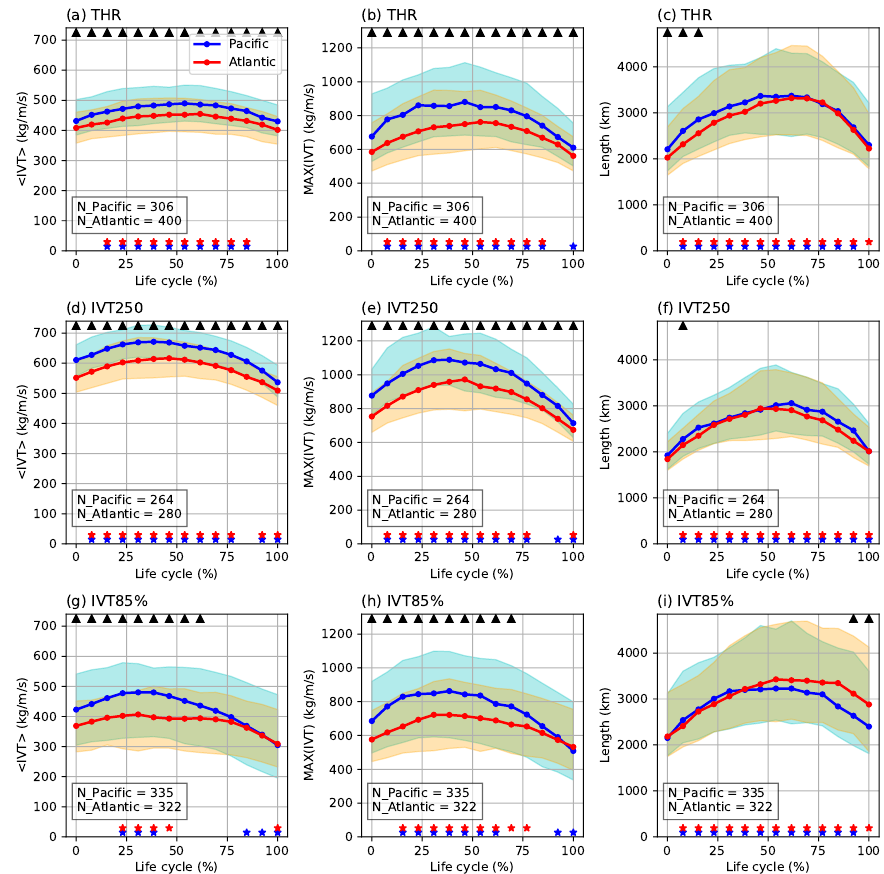
Figure 5. Lifetime evolution of mean AR IVT (left column, in kg/m/s), maximum AR IVT (middle column, in kg/m/s) and AR axis length (right column, in km) computed from AR tracks by the THR (top row), IVT250ano (middle row) and IVT85% method (bottom row). Tracks with durations of 30–120 h are selected and normalized to 0–100% life cycle. Blue (red) curve denotes the median among Pacific (Atlantic) tracks, and cyan (yellow) shading denotes the inter-quantile range. The number of tracks are labeled at bottom left. Blue (red) stars at the bottom indicate that the distribution among Pacific (Atlantic) tracks at this time point is significantly different (with p -values ≤ 0.01) from the 1st time point at 0% life cycle. Black triangles at top indicate significant ( p -values ≤ 0.01) difference between Pacific and Atlantic tracks. Significant tests are done using a 2-tailed Wilcoxon–Mann–Whitney